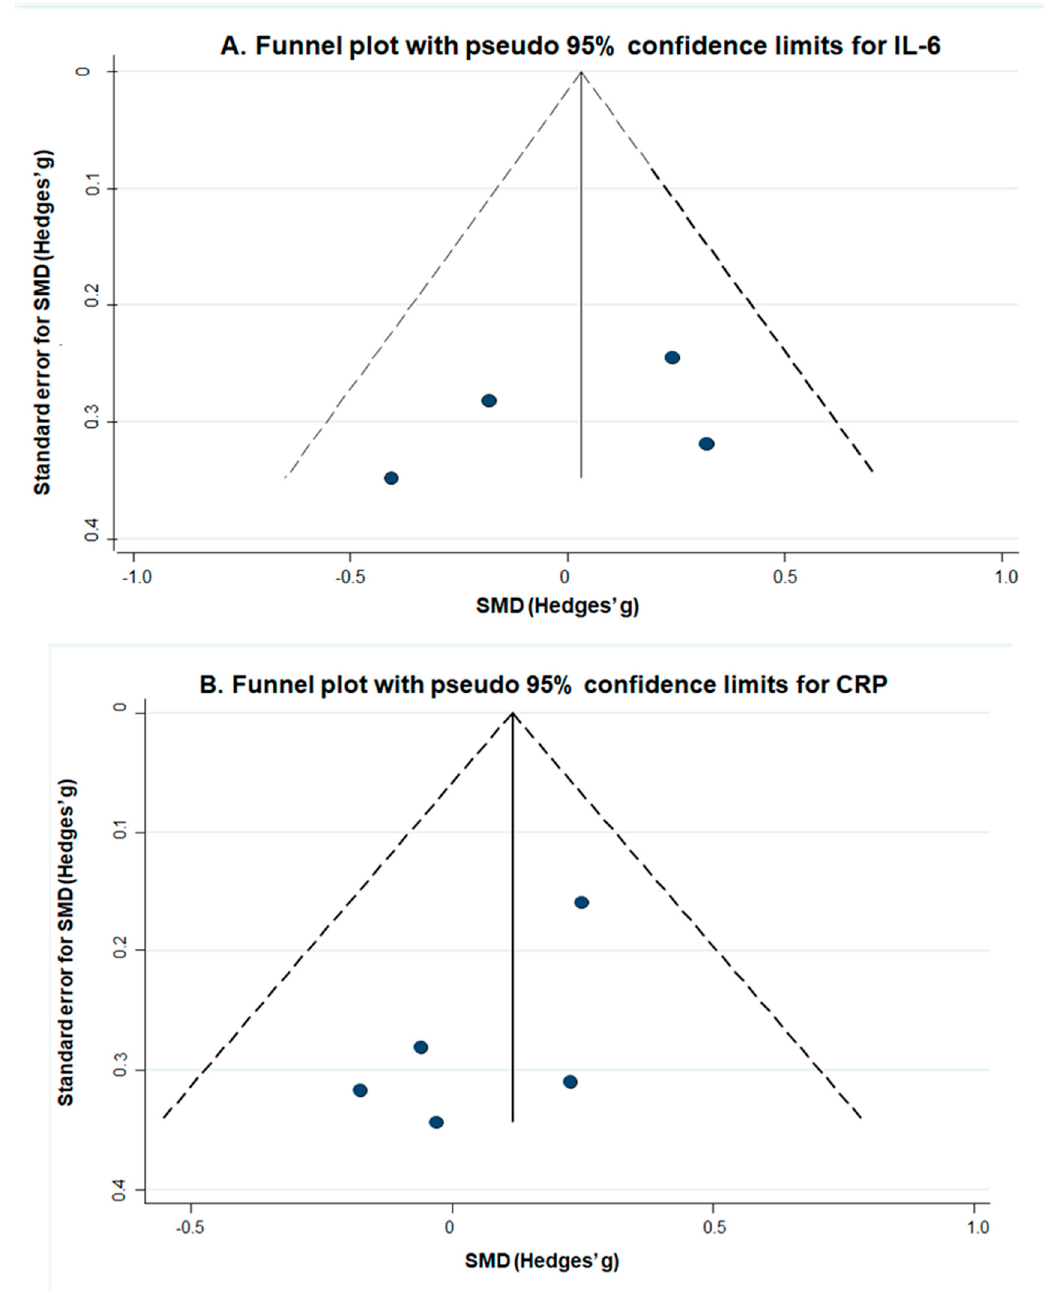
Figure A1. Funnel plots of standard error for Hedges’ g effect sizes for: ( A ) interleukine-6 (IL-6) and ( B ) acute phase reactant protein C-reactive protein (CRP).